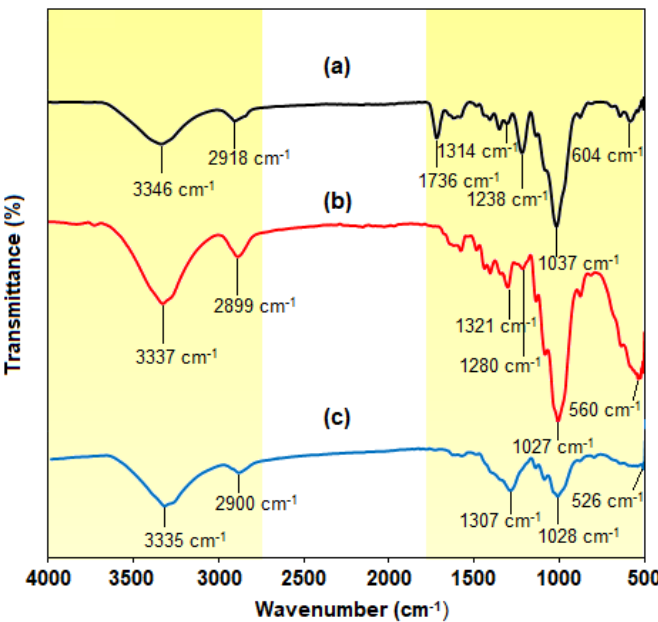
Figure 13. Fourier Transform Infrared (FTIR) spectra of ( a ) untreated C. pentandra fiber, ( b ) treated C. pentandra fiber and ( c ) C. pentandra /Ag-NPs.